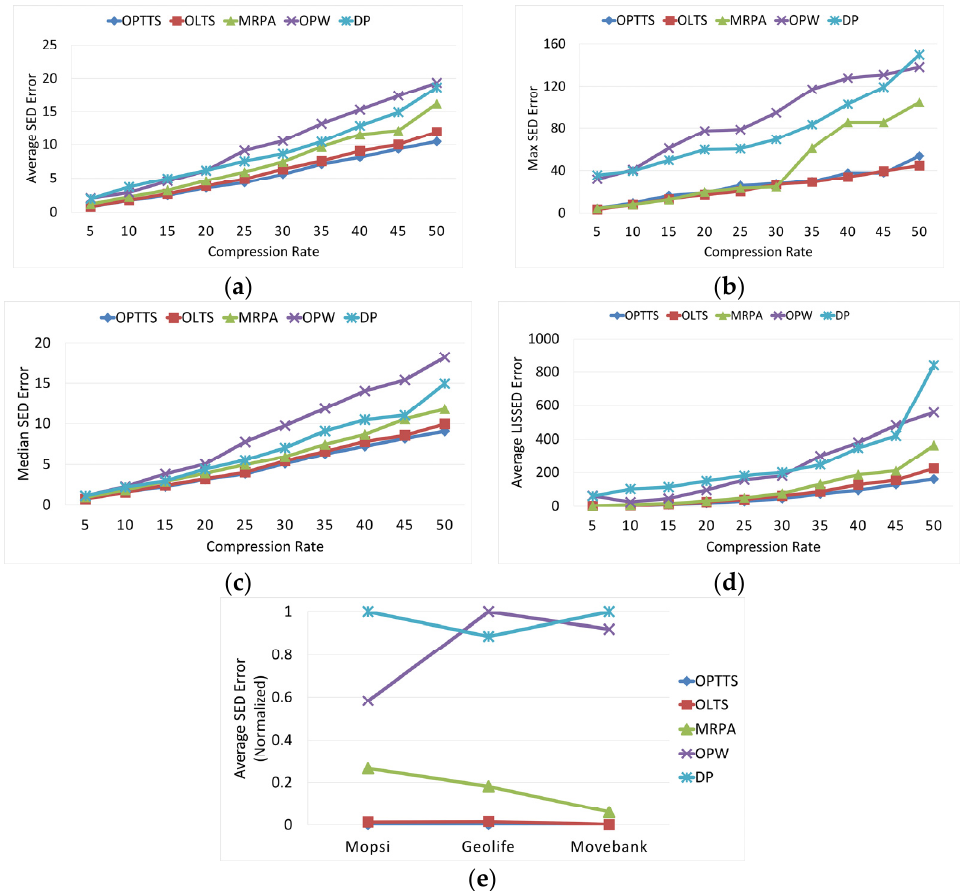
Figure 14. ( a ) Average SED error. ( b ) Max SED error. ( c ) Median SED error. ( d ) Average ISSED error. ( d ) Average SED errors on different datasets. ( e ) Average SED errors on different